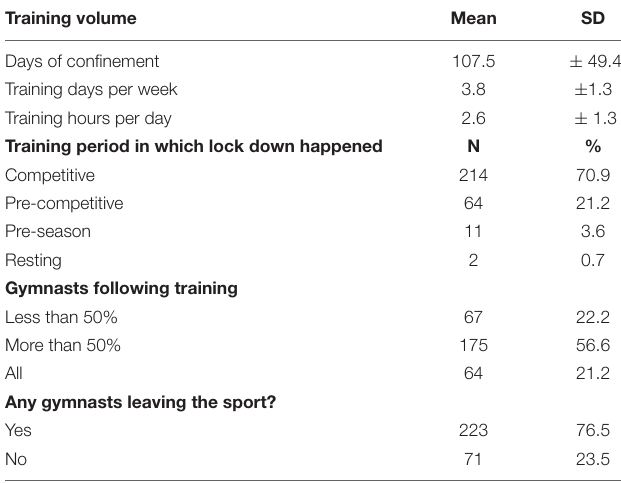
TABLE 1 | General characteristics of training during